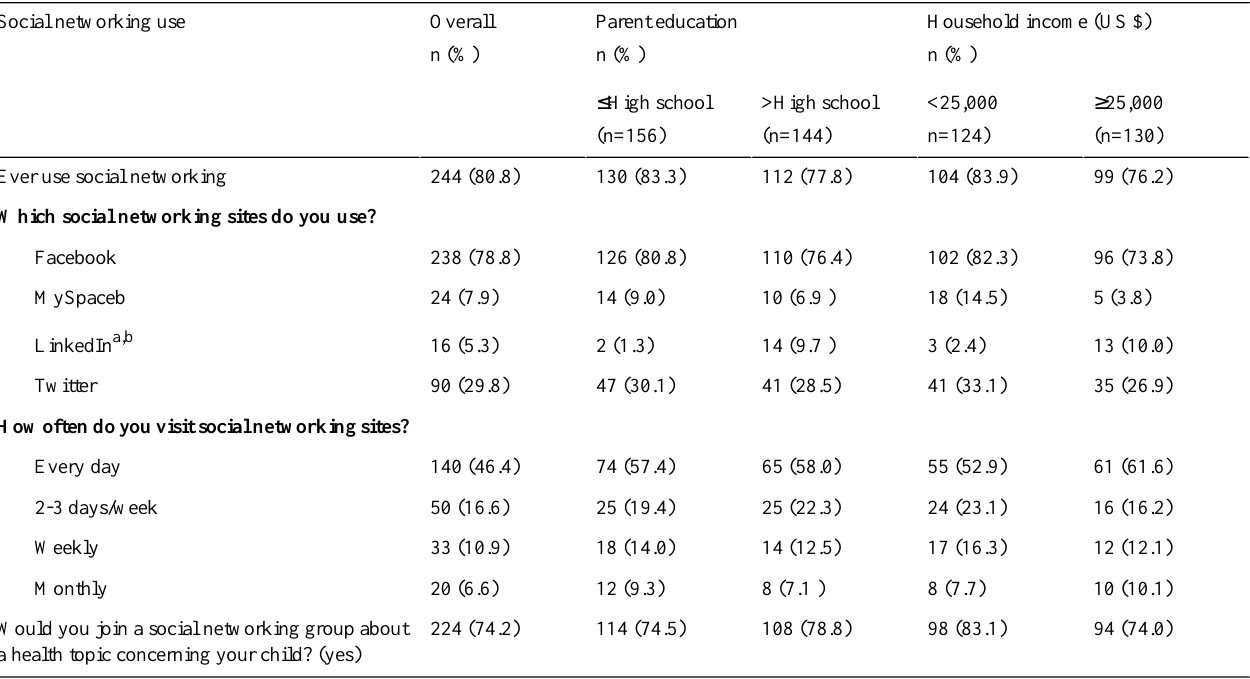
Table 5. Participant social networking by education and income (N=302).